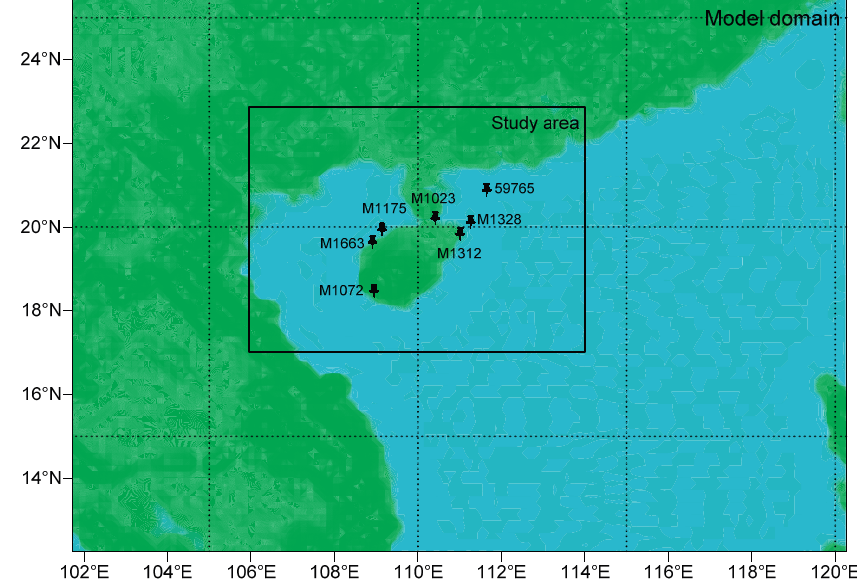
Figure 1. Map of the model domain and the study area with indication of the seven in situ